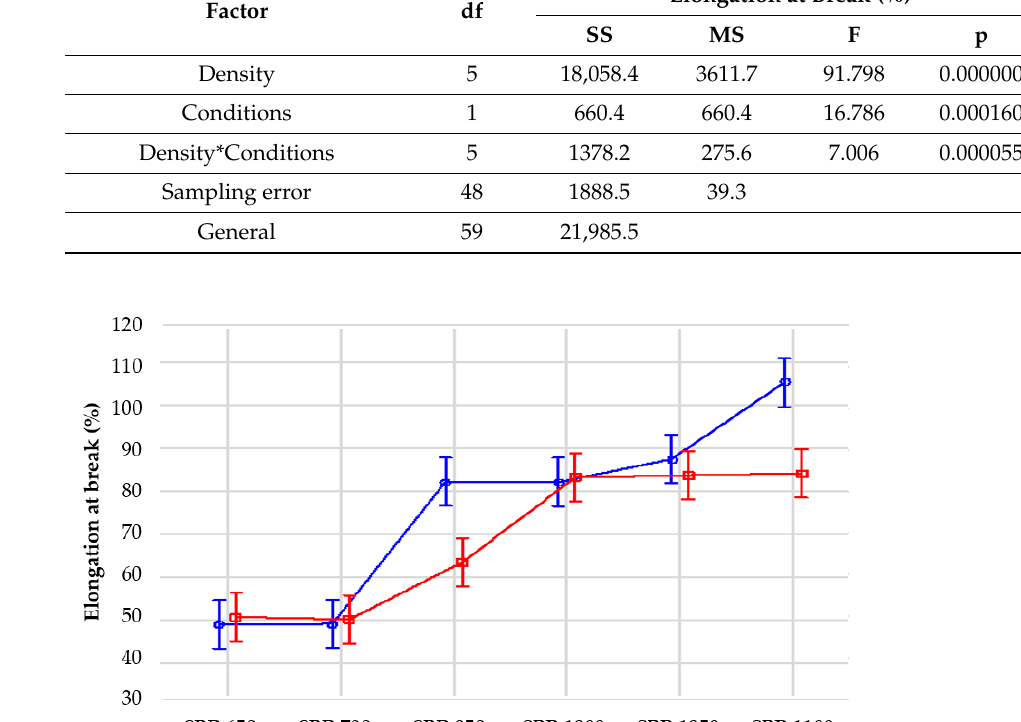
Table 4. Variance analysis for the elongation at break: SS—sum of squares, MS—mean squares,